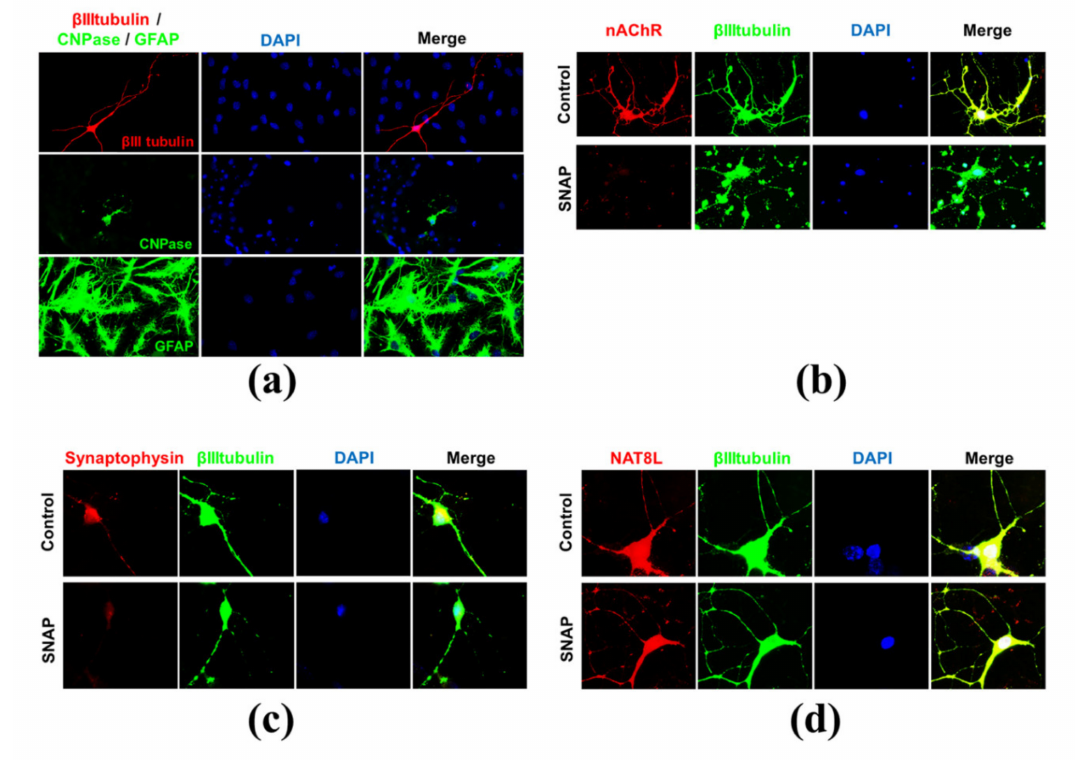
Figure 2. The immunostaining made for the purposes of this project: ( a ) cell types recognized in the neural stem cells model stained by the antibody against β -III-tubulin (neuronal marker), CNPase (2 (cid:48) ,3 (cid:48) -Cyclic-nucleotide 3 (cid:48) -phosphodiesterase, oligodendrocytic marker) and glial fibrillary acidic protein (GFAP) (astrocytic marker). The impact of 0.2 mM SNAP ( S -Nitroso- N -acetylpenicillamine) on primary neurons stained by the antibody against β -III-tubulin and: ( b ) nicotinic acetylcholine receptor (nAChR); ( c ) synaptophysin; ( d ) NAT8L. The images are representative for four independent sets of